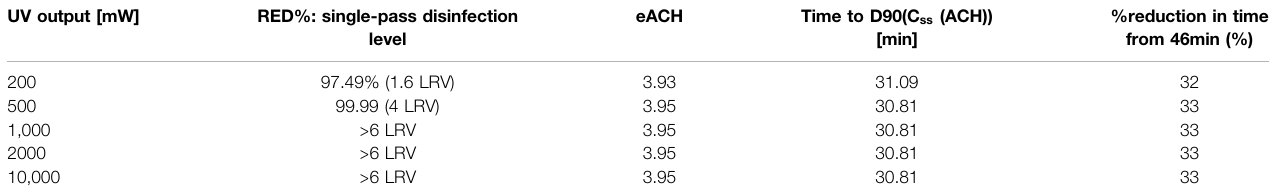
TABLE 4 | Impact of UVC on a similar system presented in Table 3 , however with recirculation rate reduced from 160 m 3 /h to 30 m 3 /h. UV output